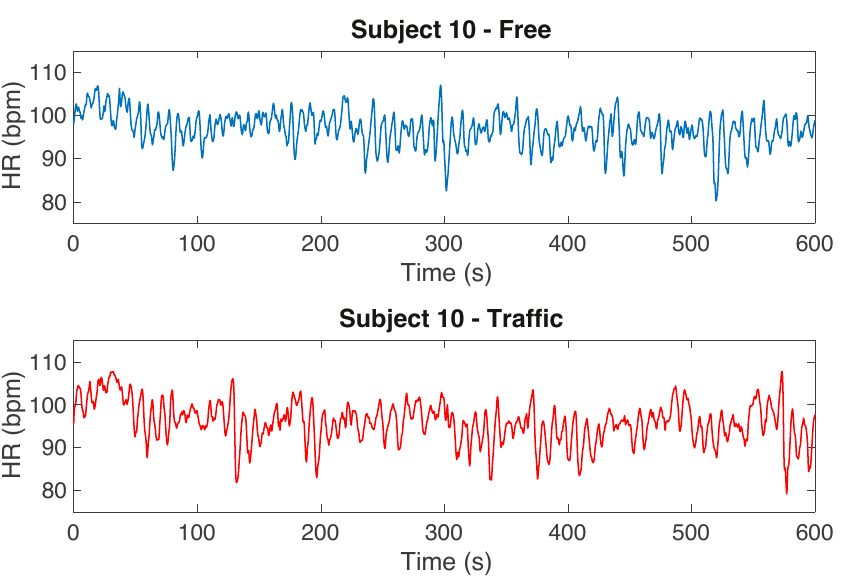
Figure 9. HR signal for Subject 10 in the two scenarios: without traffic ( top ) and with traffic ( bottom